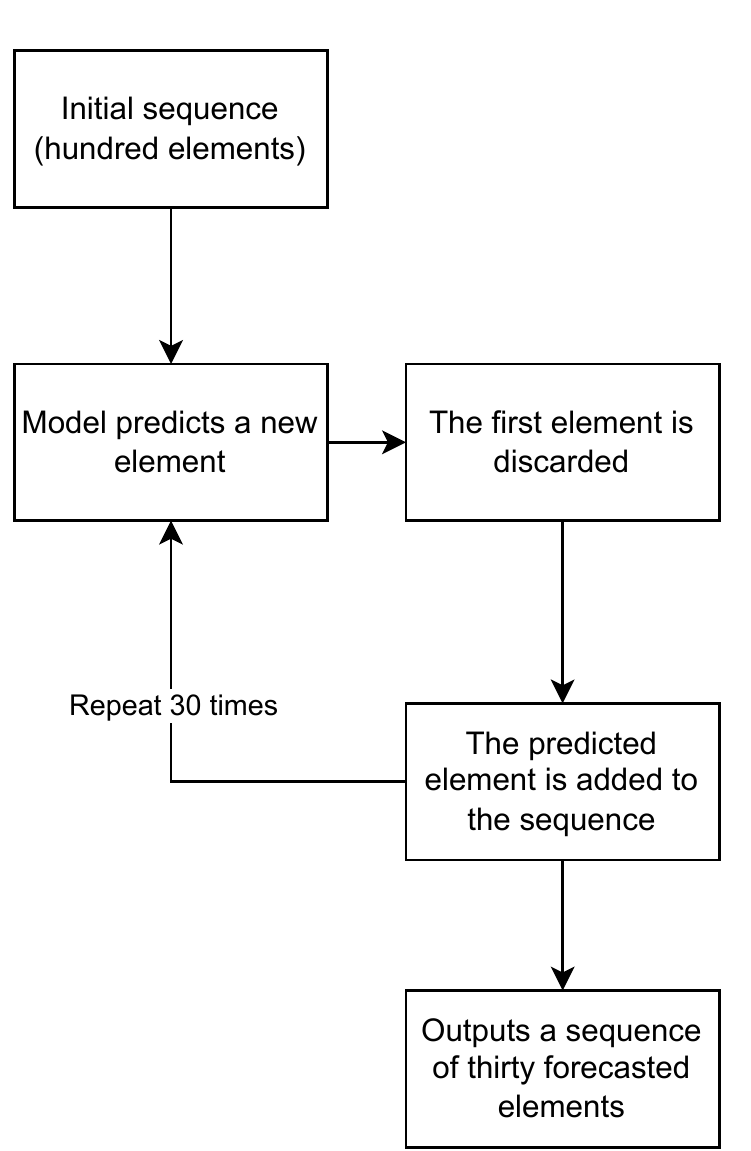
Figure 12. Algorithm used to obtain 30 forecasted